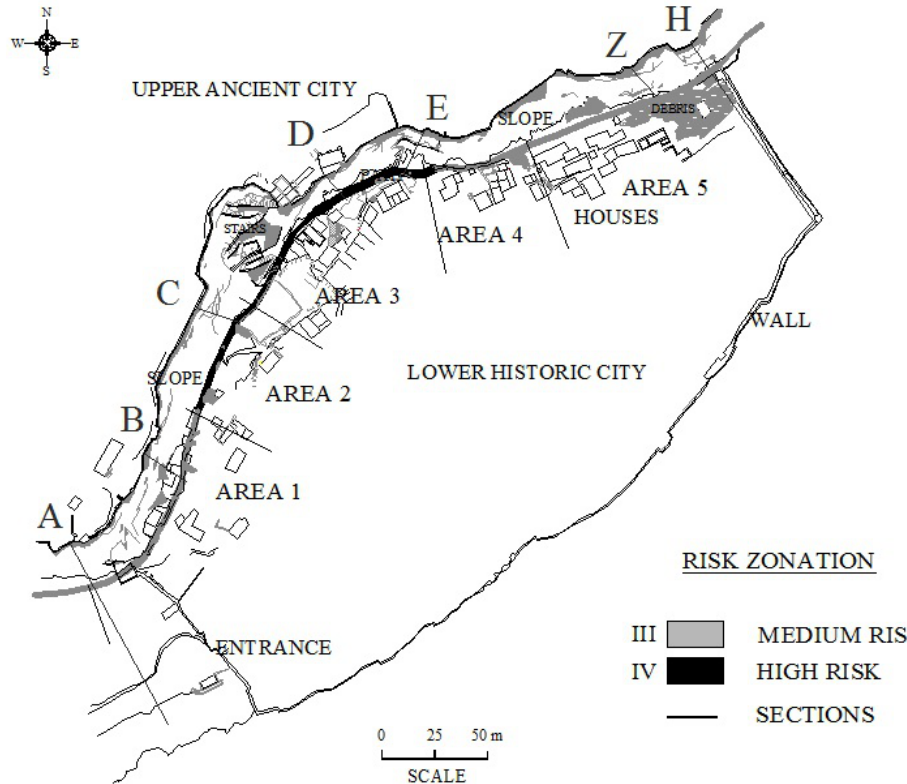
Fig. 11. Risk zonation of rock slope based on proposed rockfall risk rating